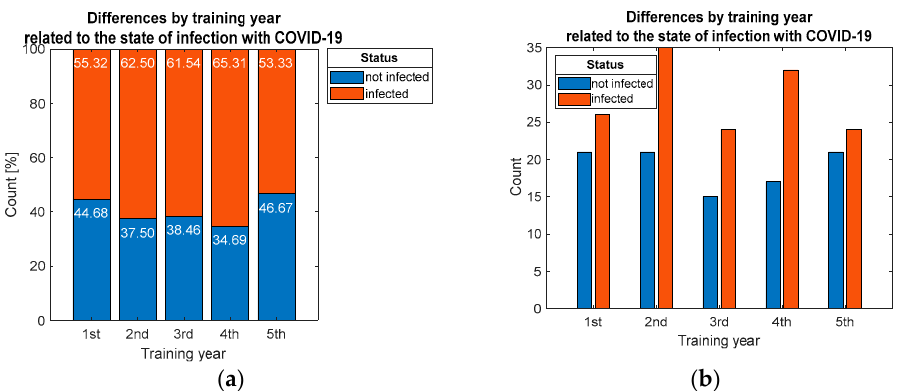
Figure 6. Distribution of respondents by: ( a ) percentage and ( b ) count considering differentiation by training year.